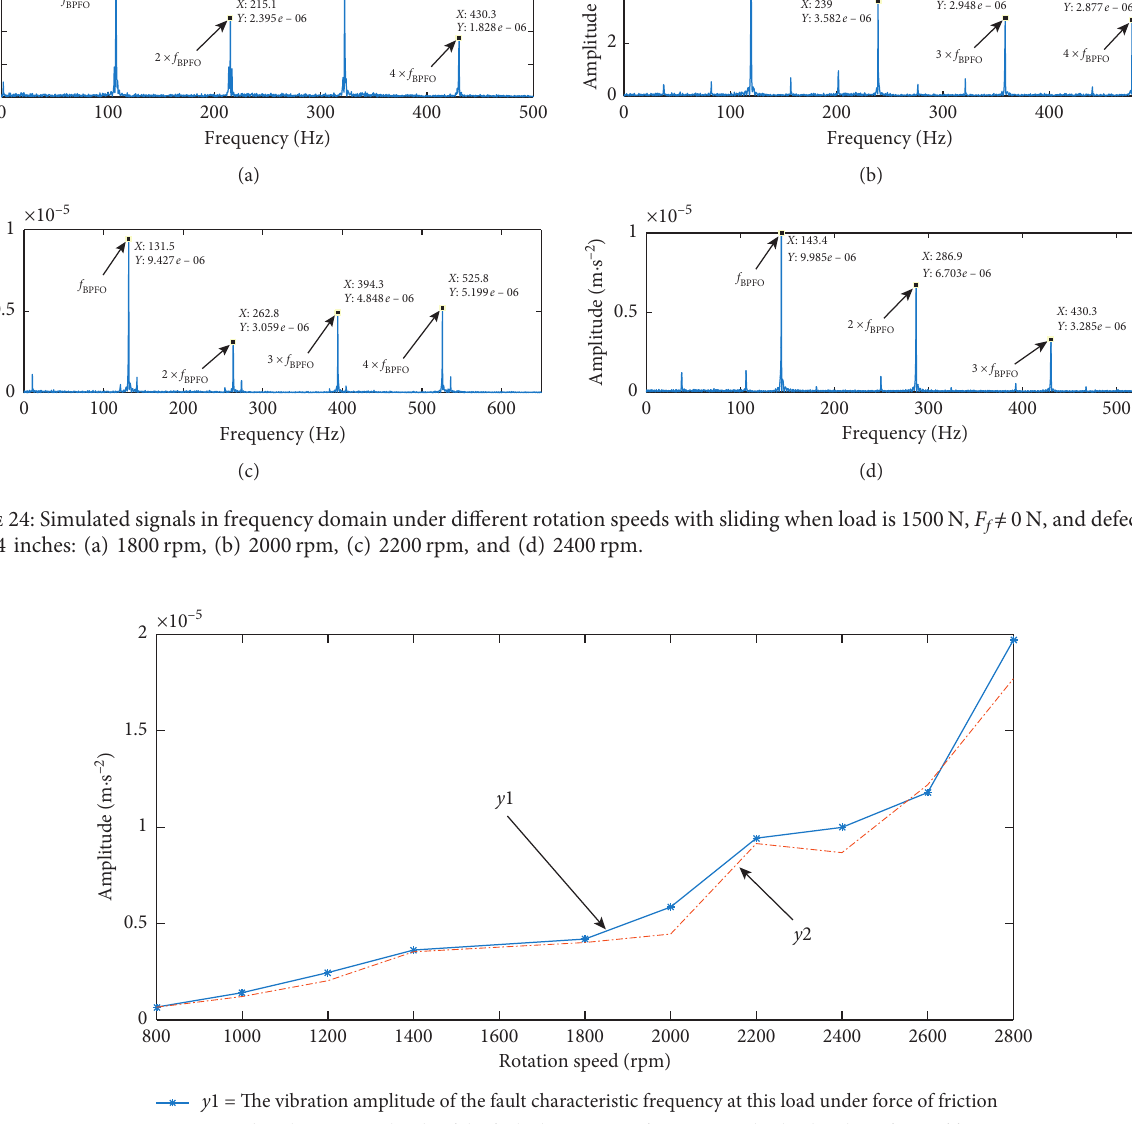
Figure 25: Amplitude trends of characteristic frequency with friction and no friction at the 1500N under different rotation speeds when the defect size is 0.014